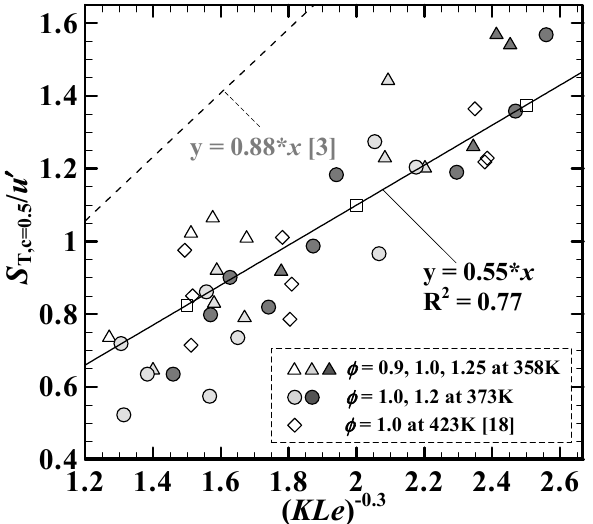
Figure 6. Normalized turbulent burning velocities of iso-octane/air mixtures using the Bradley’s correlation [3]: S T, 𝑐̅ =0.5 / u ′ = 0.55( KLe ) –0.3 . The dashed line was the original version of previous data obtained by Bradley et al. [3], where S T, 𝑐̅ =0.5 / u ′ = 0.88( KLe ) –0.3 .